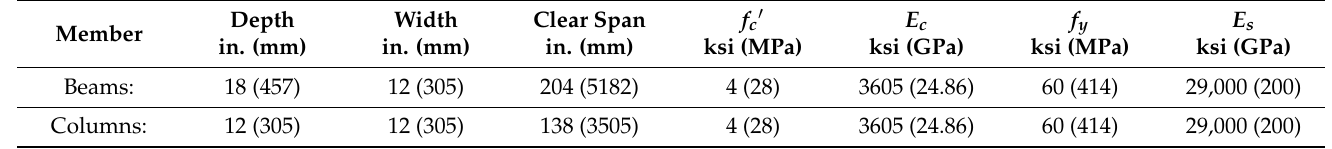
Table 1. Preliminary chosen sizes of beams and columns and basic material